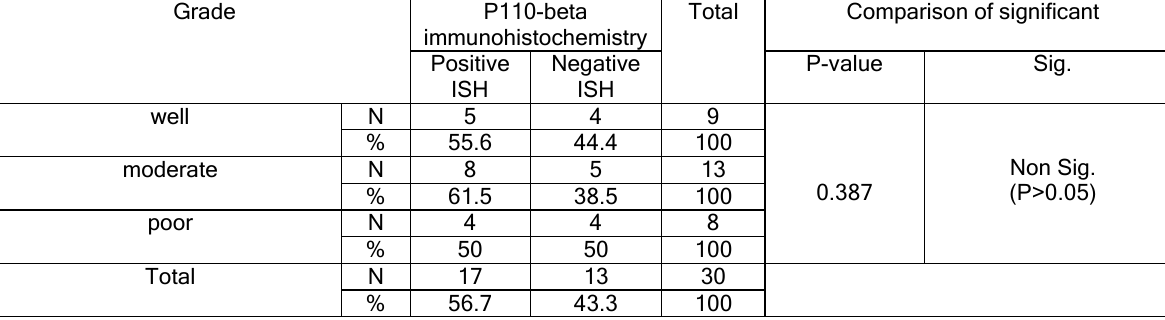
Table (4): The distribution of IHC results for P110-beta detection according to the grading of breast carcinoma :-